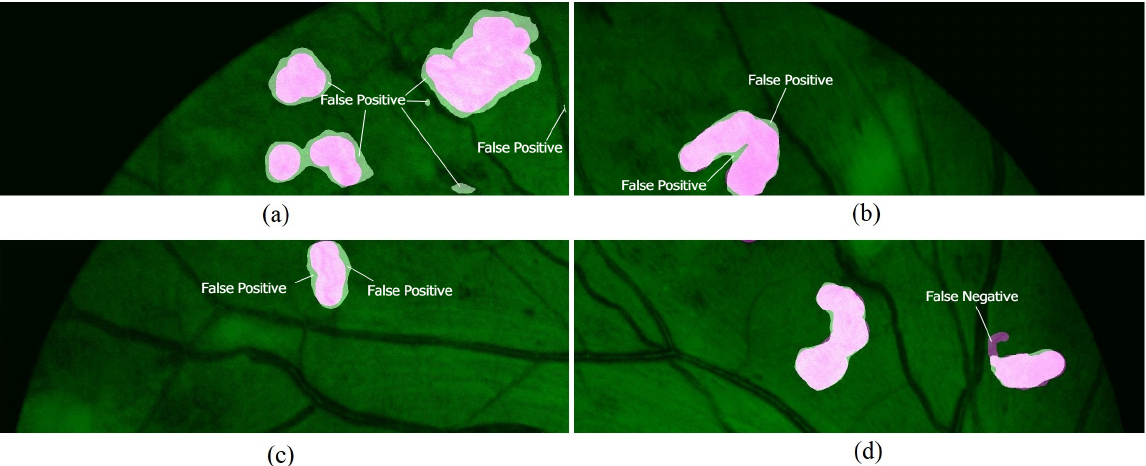
Figure 9. Examples of output images from the proposed network. Some false positives areas are labeled in ( a – c ). A false negatives area is labeled in ( d ).